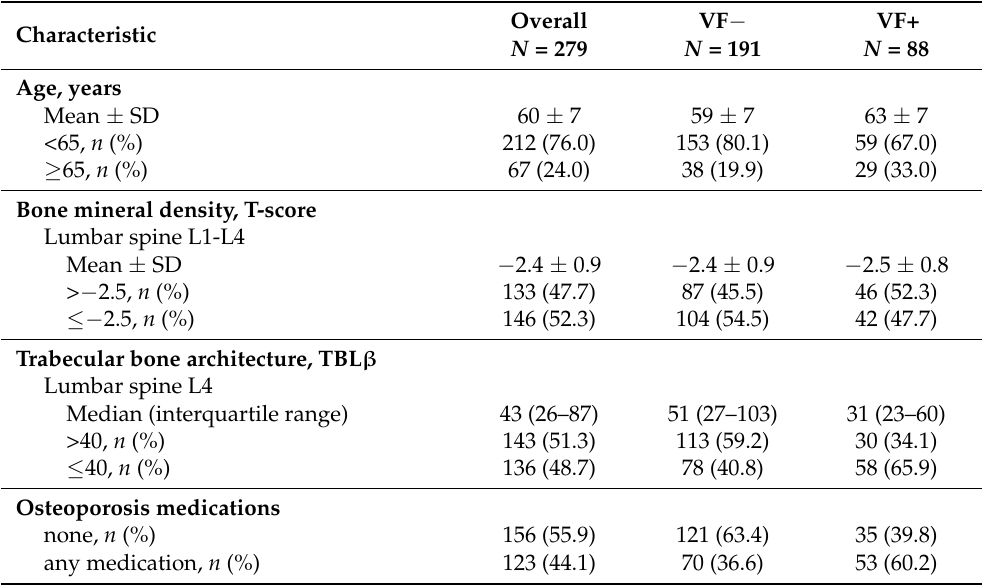
Table 1. Baseline demographic and clinical characteristics of LOTO